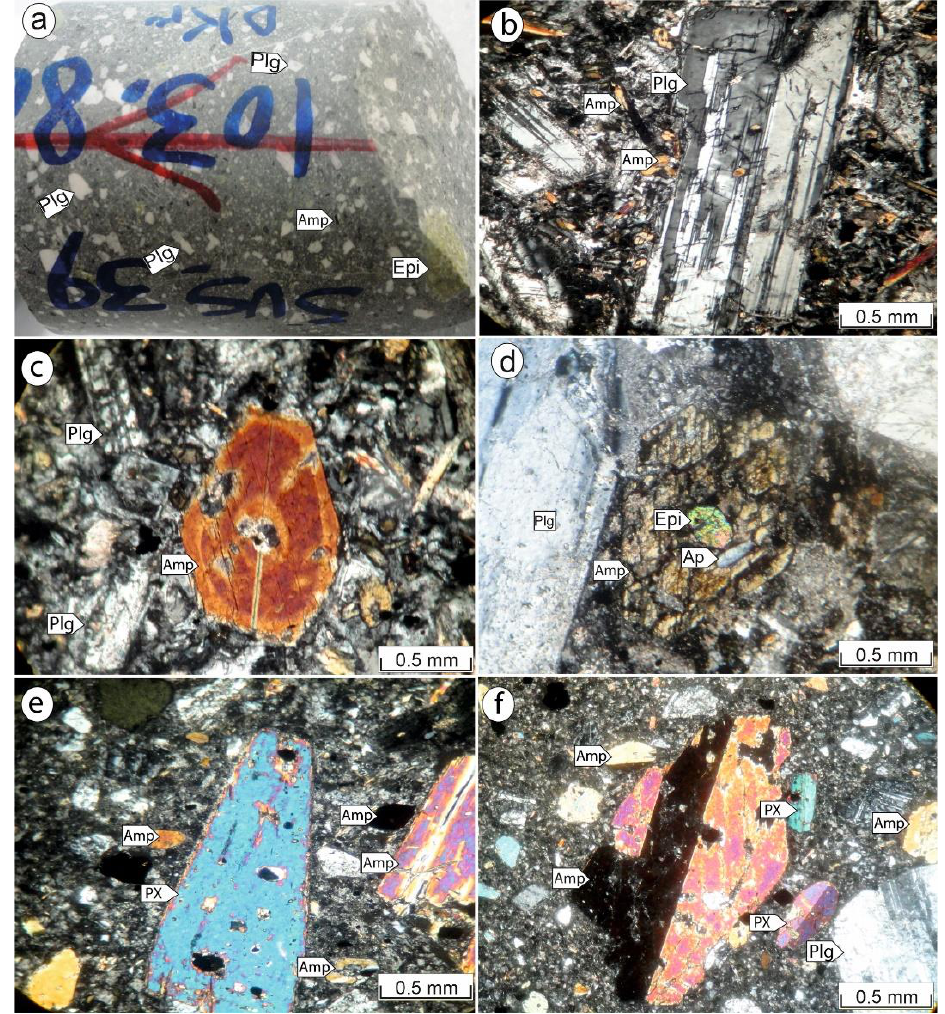
Figure 4. ( a ) A hand specimen from the dioritic dykes (coarse plagioclase (plg), epidote (Epi) and amphibole (Amp)); ( b ) plagioclase phenocrysts exhibiting twinning; ( c ) euhedral amphiboles and plagioclase. ( d ) Alteration in amphibole and plagioclase in diorite dykes; ( e , f ) pyroxene in diorite dykes (DK3).